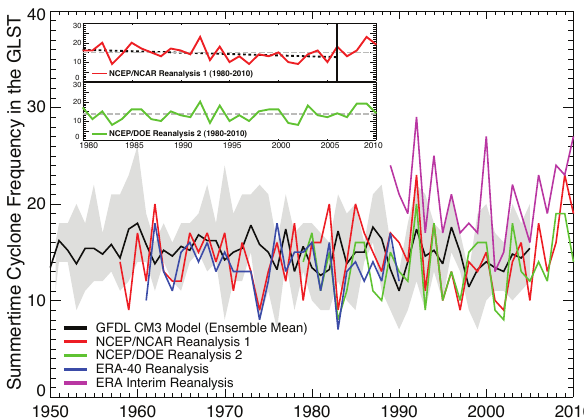
Fig. 3. Summer (JJA) 1950–2010 cyclone frequencies in the GLST as simulated with the GFDL CM3 model Historical ensemble (1860–2005) mean (black), range between the maximum and min- imum members (gray shading), NCEP/NCAR Reanalysis 1 (1961– 2010; red), NCEP/DOE Reanalysis 2 (1979–2010; green), ERA-40 Reanalysis (1961–1990; blue), and ERA Interim Reanalysis (1989– 2010; pink). The inset shows 1980–2010 JJA GLST cyclone fre- quency from NCEP/NCAR Reanalysis 1 (top; red) and NCEP/DOE Reanalysis 2 (bottom; green), the mean cyclone frequency (gray) and significant ( p < 0 . 05) trends from an ordinary least-squares regression (black dashed line). A significant decreasing trend oc- curs only in the NCEP/NCAR Reanalysis 1 cyclone frequency from 1980–2006, the period studied by Leibensperger et al. (2008), but we cannot reject the null hypothesis (zero trend) when the entire 1980–2010 time period is examined or with the NCEP/DOE